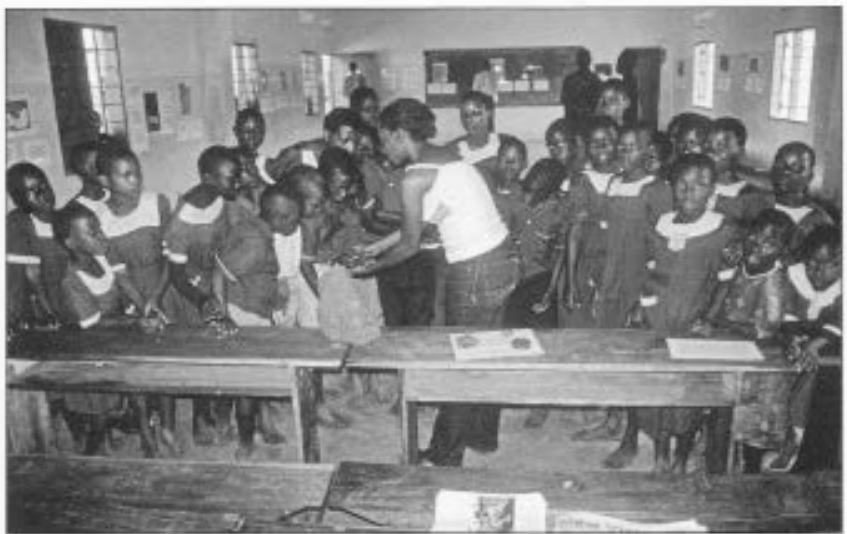
Figure 7 Rosette Mulinde with children from Luka Primary School, near Kinanisi. colonial aut h orities, to counter an epi­ demic of sleeping sickness. Bavuma